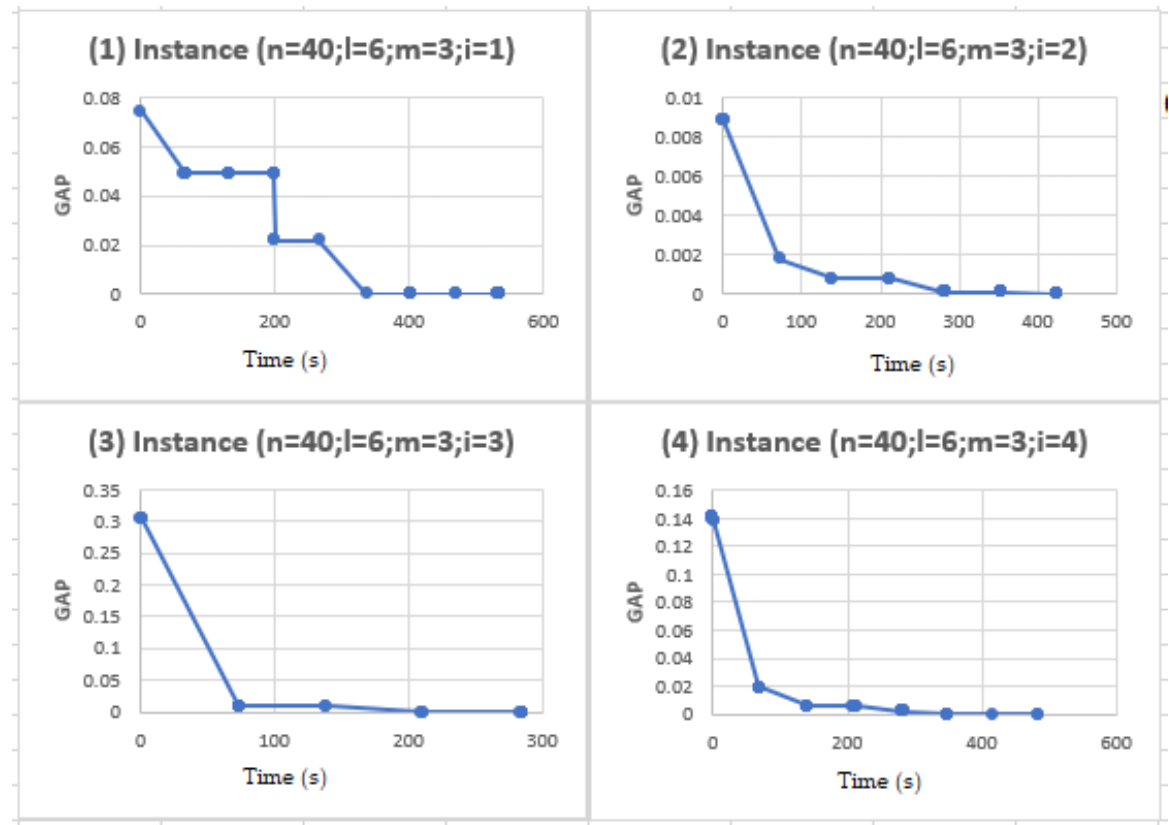
Figure 4. Behavior of the proposed MA for the EDPRP.